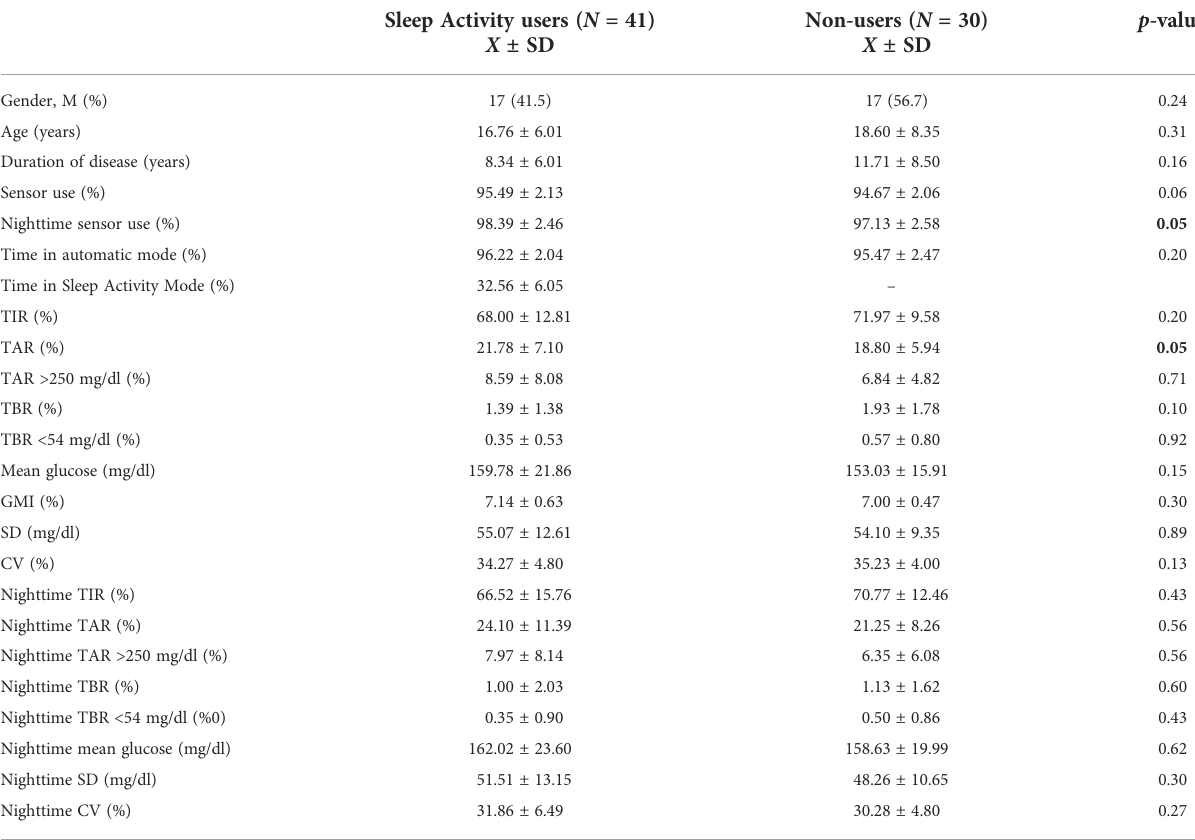
TABLE 2 Comparison of the overall and nighttime (h 24-6 – ) glycemic control of Sleep Activity Mode users (group 1) and non-users (group 2); analysis included patients using sensor and automatic mode ≥ 90% ( N = 71). Sleep Activity users ( N =